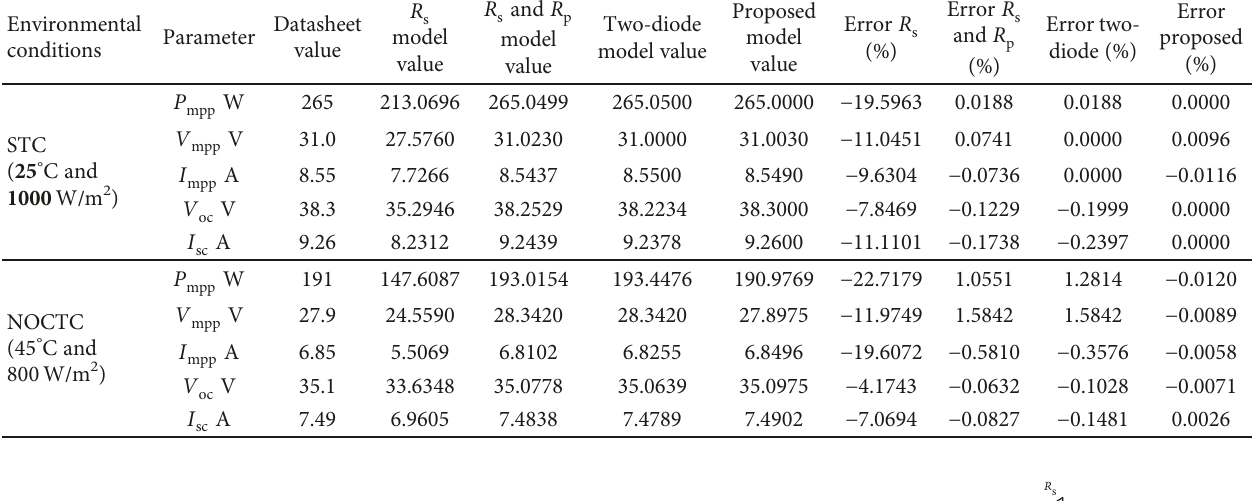
Table 9: Comparison of R KU265-6MCA PV module [36].